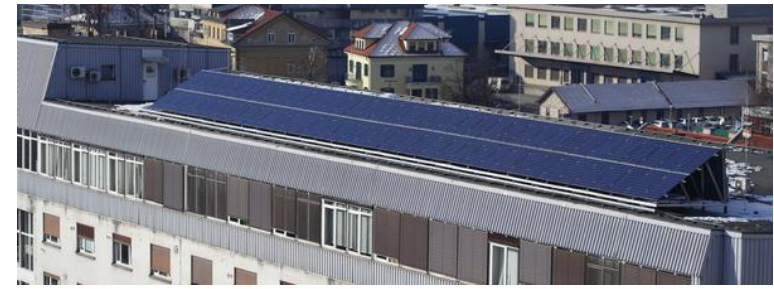
Figure 6. LPVO PV system on the roof of Faculty of Electrical Engineering in Ljubljana.